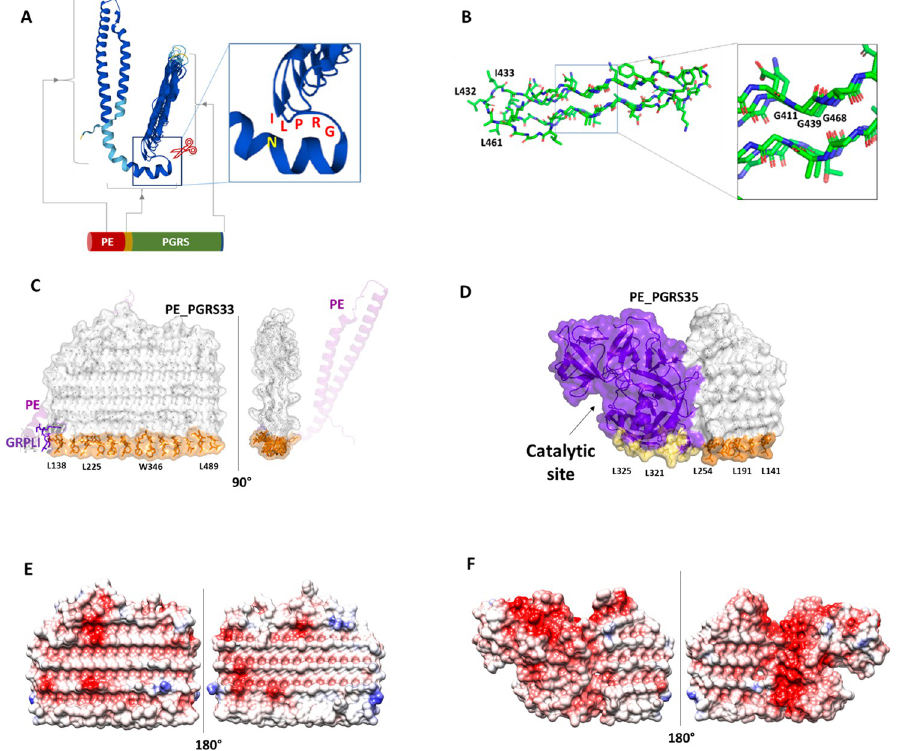
Fig 1. Structural features of PE_PGRS. (A) A schematic view of the organization of a PE_PGRS protein in PE, linker, and PGRS domain. The conserved GRPLI is highlighted. (B) Stick representation of our previously proposed structural model of a PGRS PG II sandwich domain [4,5];hydrophobic residues on 1 edge and conserved glycine residues pointing inwards the PG II sandwich are labeled. (C, D) Structural representation of PE_PGRS33 and PE_PGRS35 structures, respectively. PE_PGRS33 PE domain is shown in magenta cartoon, the PGRSs domains in white stick/ surface, the PE_PGRS35 catalytic domain in prune cartoon/surface. Hydrophobic residues lining the straight edges of the PGRS33 and PGRS35 domains are colored orange, those of PE_PGRS35 catalytic domain in yellow. (E, F) Two 180˚ views of electrostatic potential surfaces of PGRS33 and PGRS35, respectively.